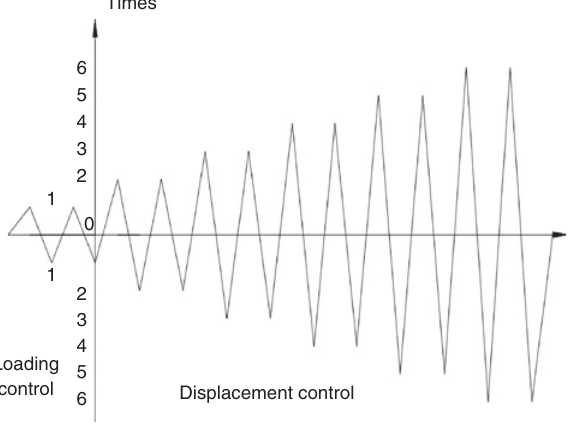
Figure 4: Loading steps.